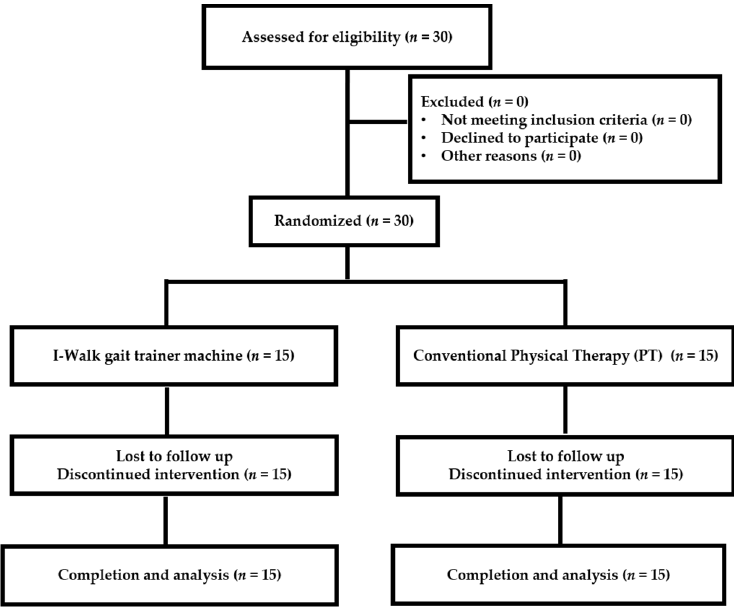
Figure 1. Flowchart representing the number of patients throughout the trial measures.